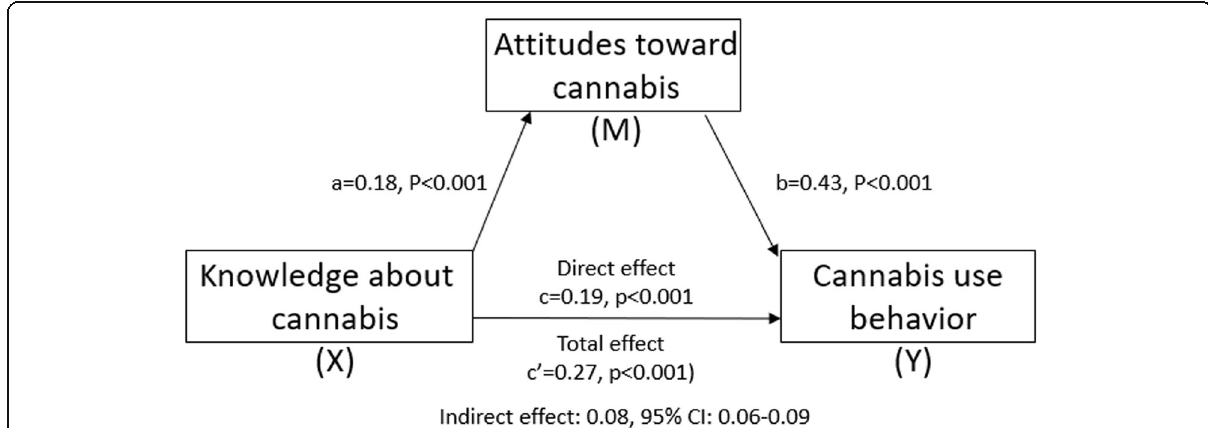
Fig. 2 Mediation analysis of attitudes, knowledge, and cannabis use in adult athletes. Effects are standardized coefficients. The X to M path is the effect of knowledge about cannabis on attitudes toward cannabis. Attitudes is coded as 1 = Conservative, 2 = Unsure, 3 = Unsure; Conservative is the comparison group. Knowledge is continuous 0 – 4. The M to Y path is the effect of attitudes toward cannabis on cannabis use. Cannabis use is coded as: 1 = Never use, 2 = Past Use, 3 = Current Use. The Direct effect is the effect of knowledge on use adjusted for attitudes. The Total